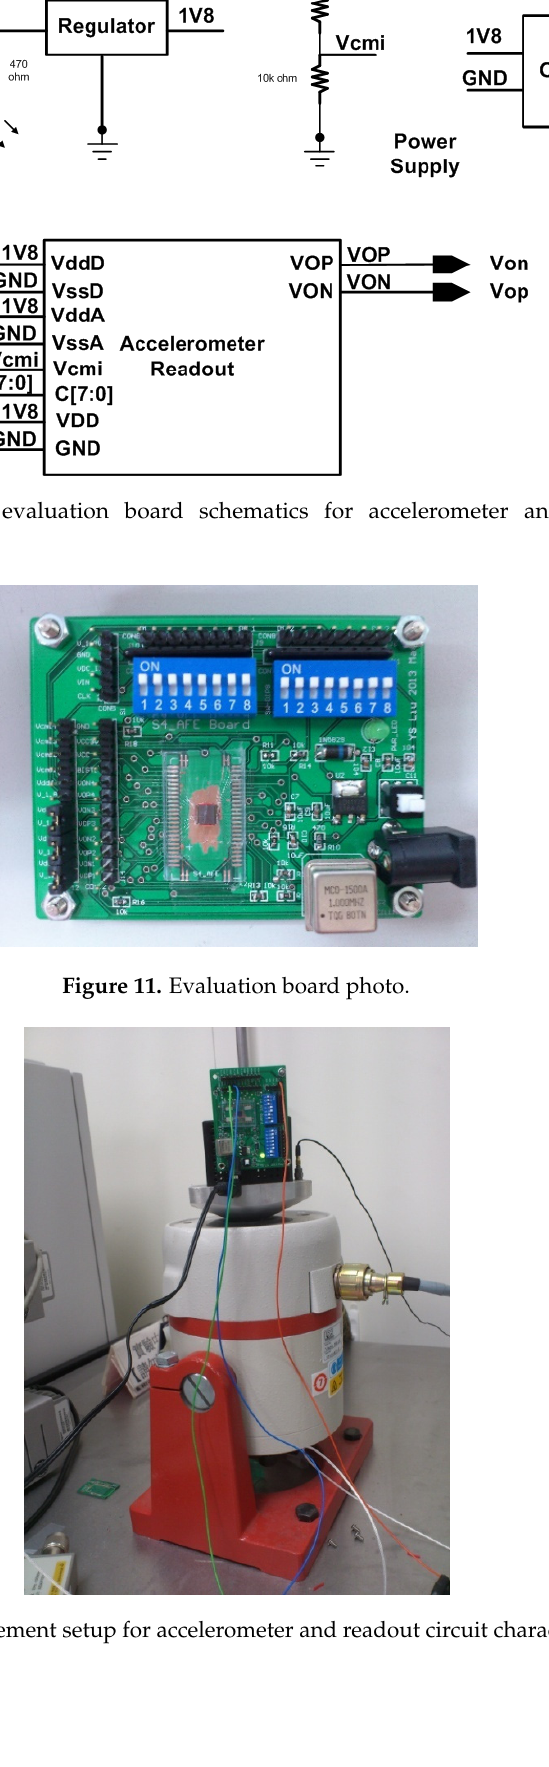
Figure 10. Simplified evaluation board schematics for accelerometer and readout circuit characterization.